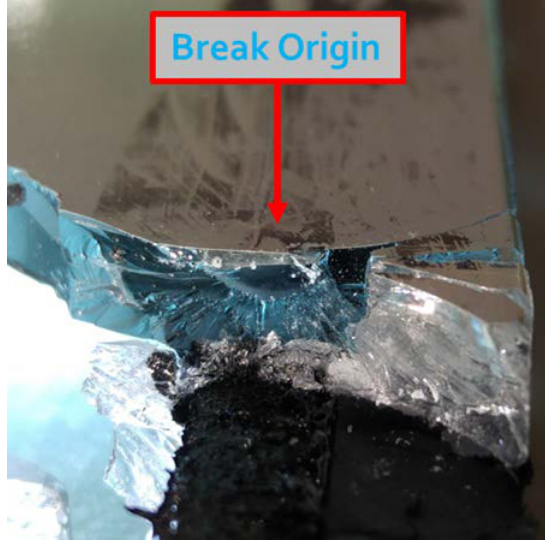
Figure 2. Ceramic enamel frit opacifier on spandrel glass with the thermal stress fracture located where frit material interfaces with